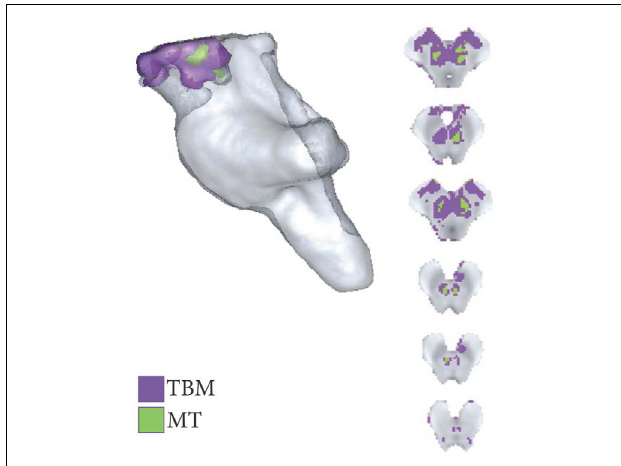
FIGURE 4 |Areas of significant regional decreases in tissue volume and magnetization transfer, binarized at p < 0.001 uncorrected